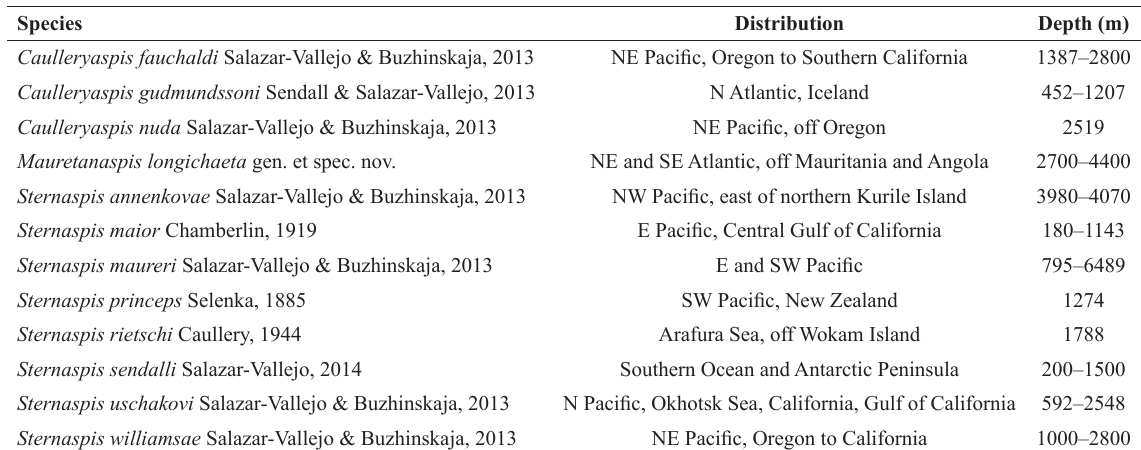
Table 1. Deep-water Sternaspidae known to